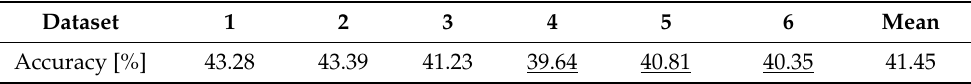
Table 3. Recognition accuracy in respective datasets. The underlines indicate used datasets. Dataset